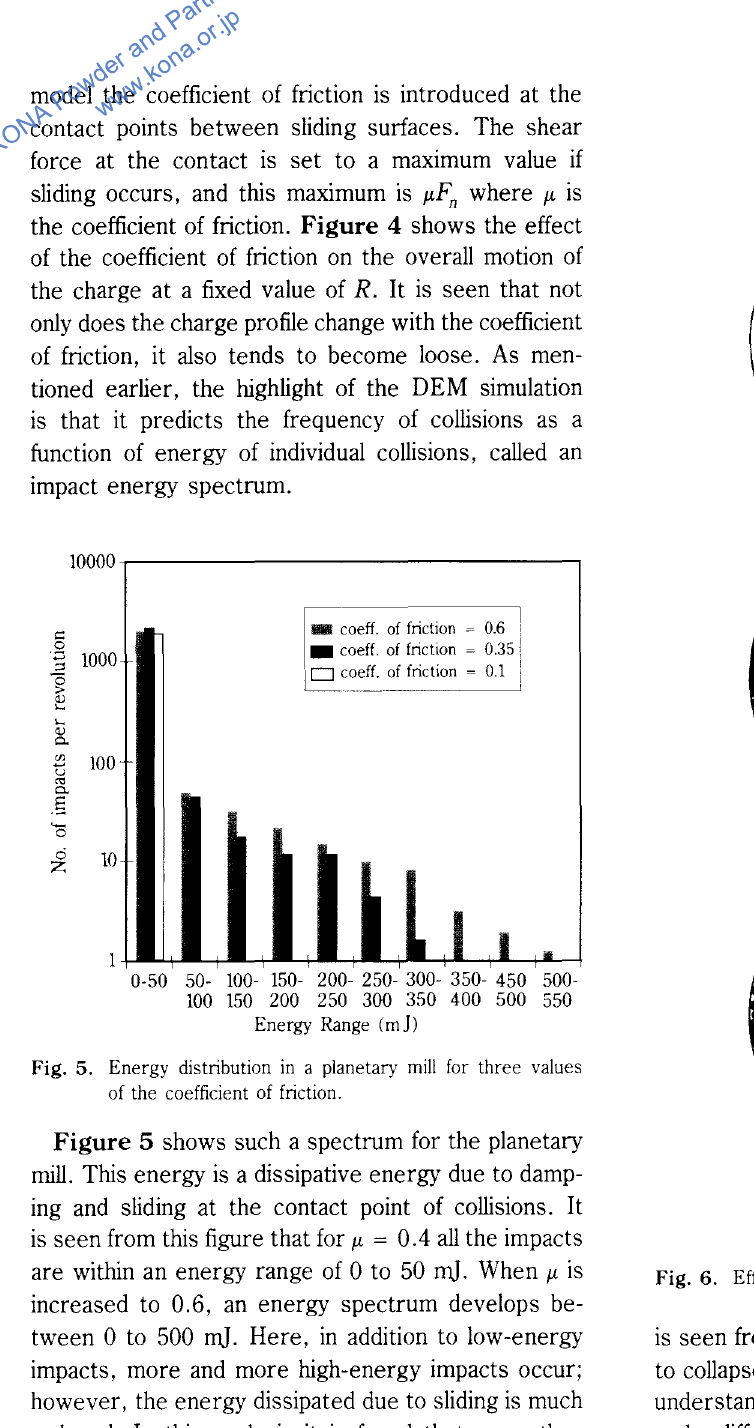
Fig. 6. Effect of ball filling on charge motion; R = -